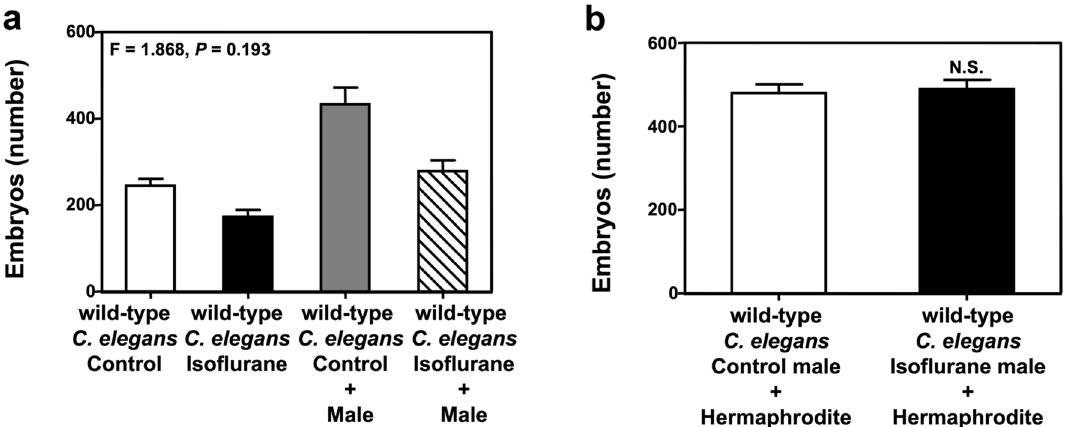
Figure 5. Mating with male C. elegans did not attenuate the isoflurane-induced changes in oogenesis. ( a ) Wild- type N2 hermaphrodites were treated with 7% isoflurane for 4 h. Then, five male C. elegans were transferred into each plate for mating with one hermaphrodite for 12 h. The number of embryos was significantly lower in the isoflurane group than the control group with or without mating with male C. elegans . ( b ) Five male C. elegans per plate were treated with 7% isoflurane, and then every five male C. elegans mated with one hermaphrodite for 12 h. There was no significant difference in the number of embryos between the control and isoflurane groups. All data are presented as mean ± S.D., N = 10 hermaphrodites in each group. Two-way ANOVA and posthoc Bonferroni test was used to analyze the data shown in ( a ); the P values refer to the interaction of group (control condition versus isoflurane) and treatment (with versus without male C. elegans ). The Student’s t-test was used to analyze the data presented in ( b ); the P values refer to the difference between the control condition and